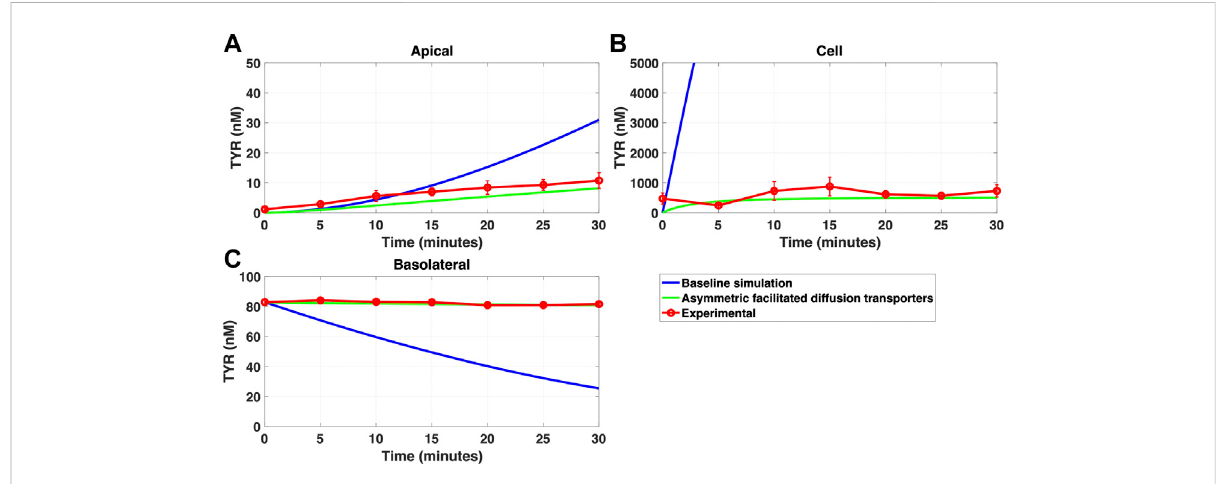
FIGURE 8 Asymmetry of OCT2 mediated transport recapitulates experimental observations following basolateral TYR loading. The transport of 82.9 nM TYR across Caco-2 cells was modeled following basolateral loading by solving Eqs 9 – 11, using the values mentioned in Supplementary Table S2, using MATLAB vR 2021a. Comparisons were made between the models (baseline = blue curve; modi fi ed = green curves) and experimental observations; red curve (Sarkar and Berry, 2020) for the apical Panel 8 (A) , cellular Panel 8 (B) and basolateral compartments Panel 8 (C) . Asymmetric OCT2 transport combined with a fully bidirectional basolateral membrane facilitated diffusion transporter allowedexperimental datato be modelled. Solved kinetic parameters from this modelling were: V max_OCT2 = 2.3 nM/s, K t _OCT2_apicaltocell = 110.4 nM, K t _OCT2_celltoapical = 1,227.9 nM, V max_baso_active = 3.3 nM/s, K t_baso_active = 29.0 nM, V max_baso_new_FD = 6.0 nM/s, K t_baso_new_FD_basotocell = 584.1 nM and K